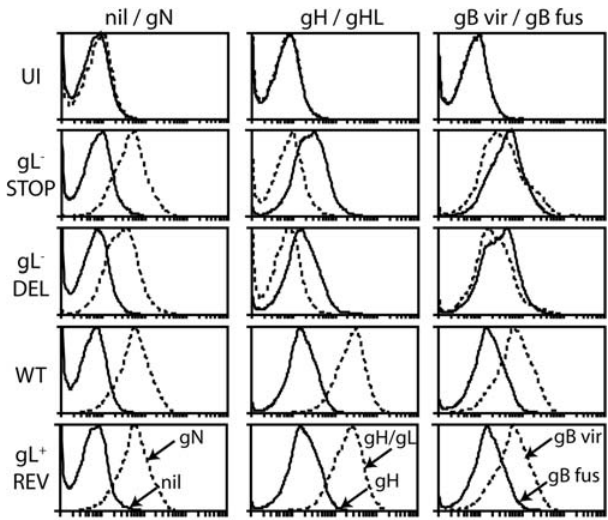
Figure 7. gL-dependent gB conformational instability in MuHV- 4-infected BHK-21 cells. BHK-21 cells were left uninfected (UI) or infected with gL 2 (gL 2 STOP, gL 2 DEL) or gL + (wild-type, gL 2 DEL revertant) viruses (2 p.f.u./cell, 18 h). The cells were then trypsinized and stained with secondary antibody only (nil, solid lines) or for gN (mAb 3F7, dotted lines), gH-only (mAb MG-9B10, solid lines), gH/gL (mAb T2C12, dotted lines), the mAb BN-1A7 + virion gB conformation (gB vir, dotted lines) or the mAb MG-1A12 + pro-fusion gB conformation (gB fus, solid lines). The data are from 1 of 3 equivalent experiments.